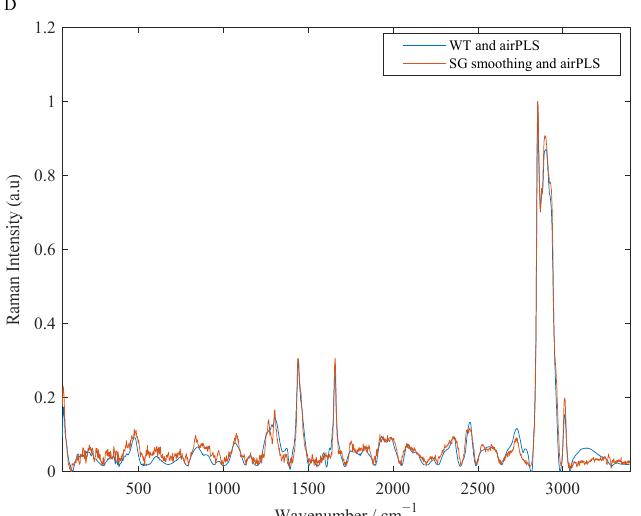
Figure 3. Raman spectra after pretreatment. ( A ) Raw Raman spectra of different degrees of mildew; ( B ) Raman spectra of different degrees of mildew after pretreatment with WT and airPLS; ( C ) Raman spectra of different degrees of mildew after SG smoothing and airPLS pretreatment; ( D ) Comparison of spectra of two preprocessing methods.